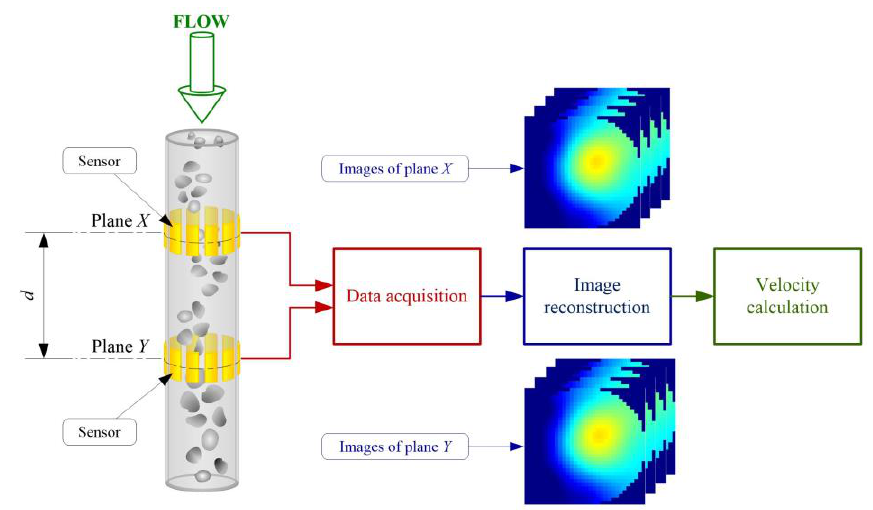
Figure 1. Material velocity measurement based on a twin plane electrical capacitance tomography (ECT) tomograph, d is the distance between two planes.